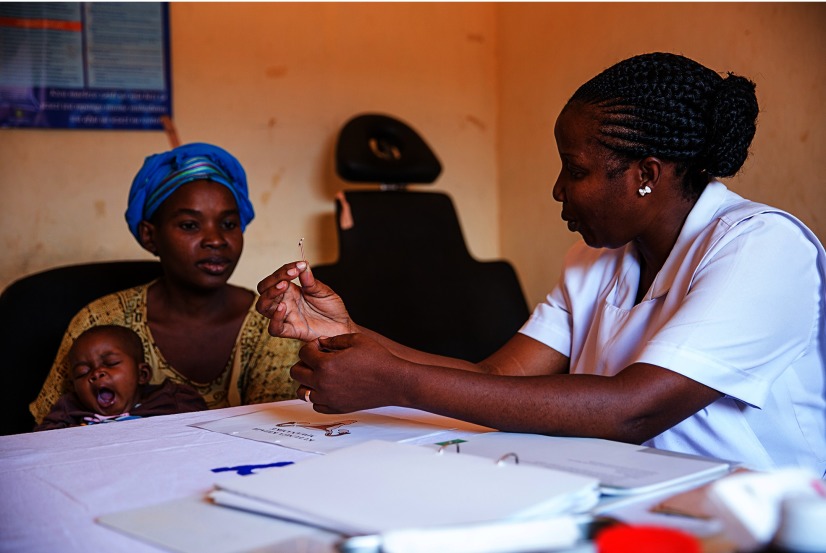
A family planning provider in Tanzania counsels a client of mobile outreach services on IUDs. © 2015 Sala Lewis/EngenderHealth